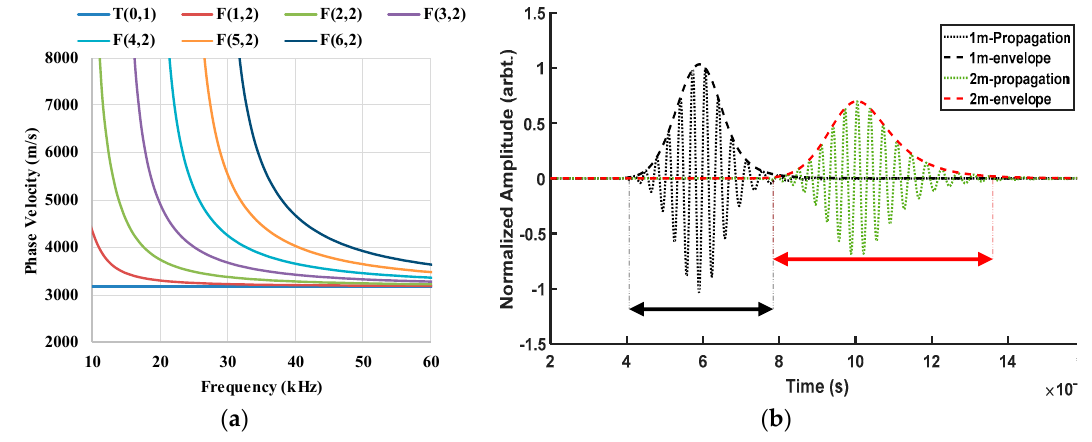
Figure 1. ( a ) Example dispersion curve of T(0,1) wave mode in an 8 ″ schedule 40 steel pipe. ( b ) The effect of dispersion on a simulated flexural wave for two propagation distances [20].